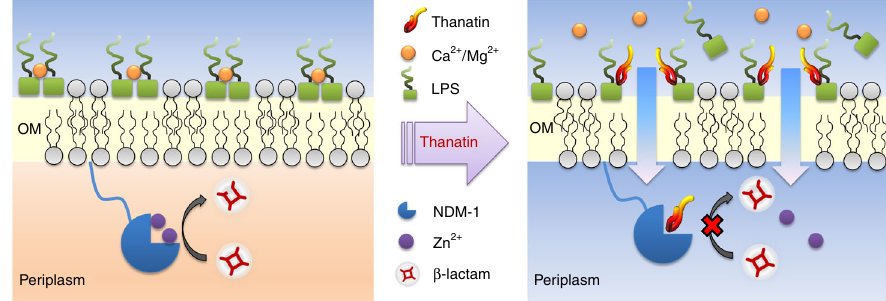
Fig. 7 Mechanism of action of thanatin. Thanatin disrupts outer membrane integrity and overcomes metallo- β -lactamase-mediated antibiotic resistance by competitively displacing divalent